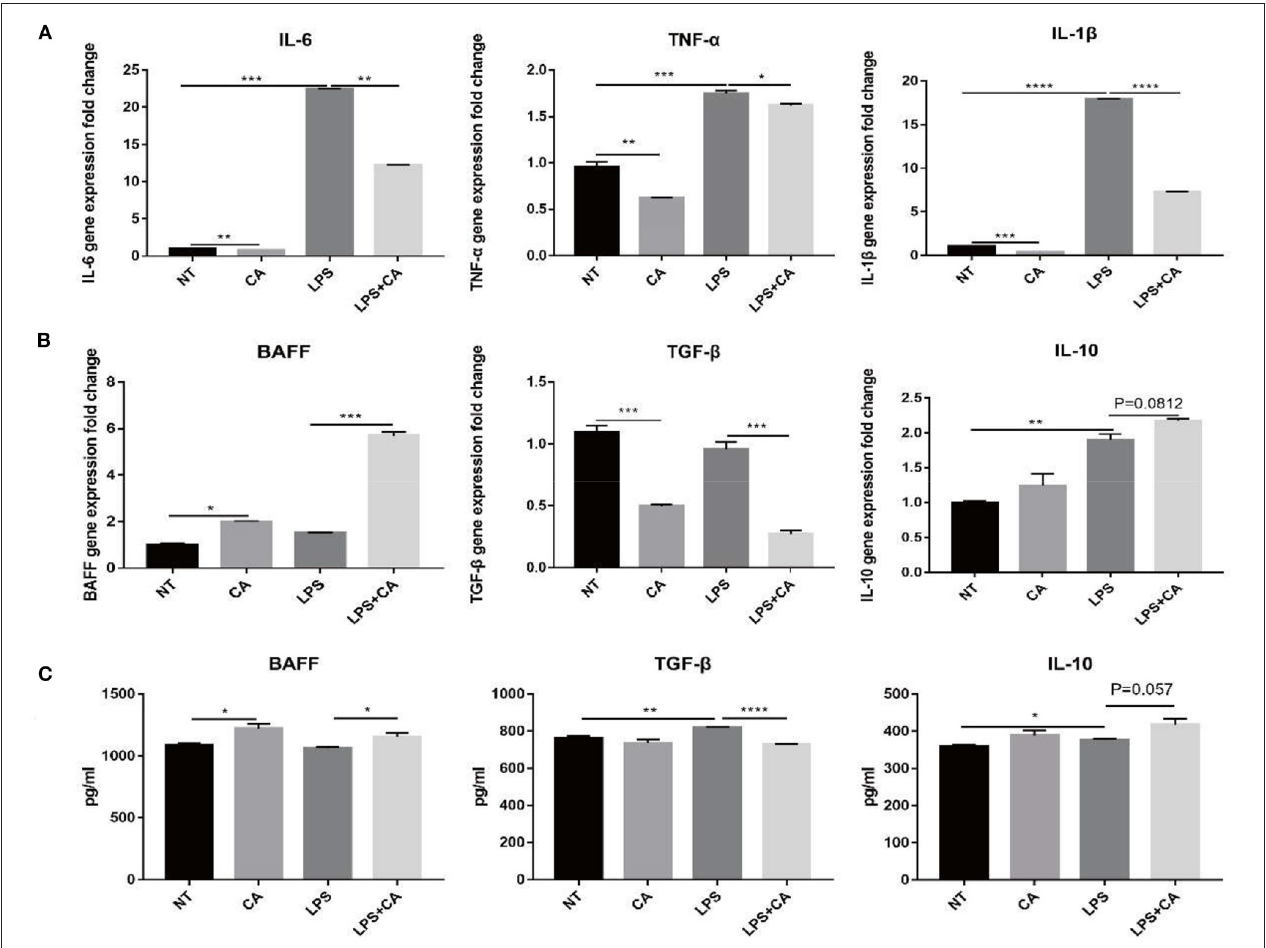
FIGURE 3 | Citric acid (CA) inhibited the overproduction of inflammatory factors in RAW264.7 cells and promoted the production of cytokines related to B lymphocyte activation. After treatment with 4 mmol/L citric acid for 2h, LPS (1 µ g/mL) was added and after 24h, the sample was collected for total RNA was extraction. (A) Expression of IL-6, TNF- α , and IL-1 β was detected by RT-PCR. (B) Expression of BAFF, TGF- β and IL-10 was detected by RT-PCR. (C) Detection of BAFF, TGF- β and IL-10 secreted in supernatants of RAW264.7 cells by ELISA ( n = 3, means ± SEM, Student’s t -test, * P < 0.05, ** P < 0.01, *** P < 0.001, **** P <